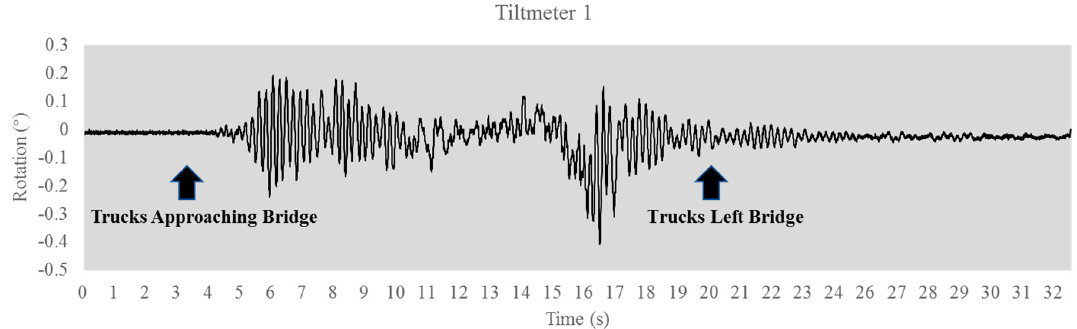
Figure 5. Tiltmeter 1 reading.